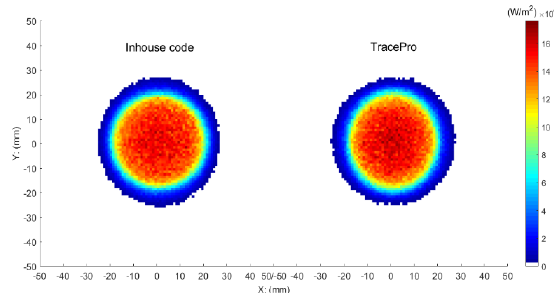
Figure 6. Focal spot simulated by in-house code in Matlab and by TracePro ® .